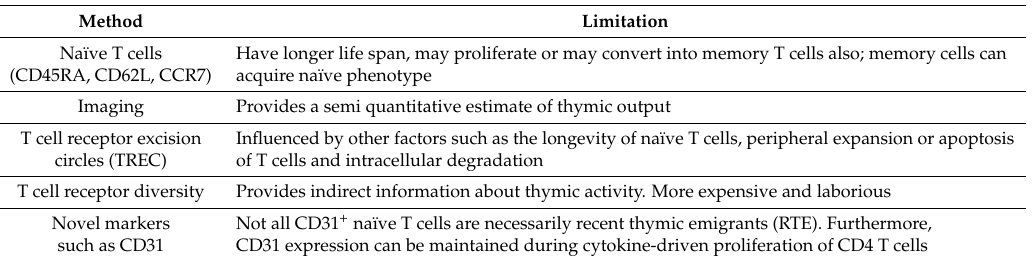
Table 1. Alternative methods used to estimate thymic output and their